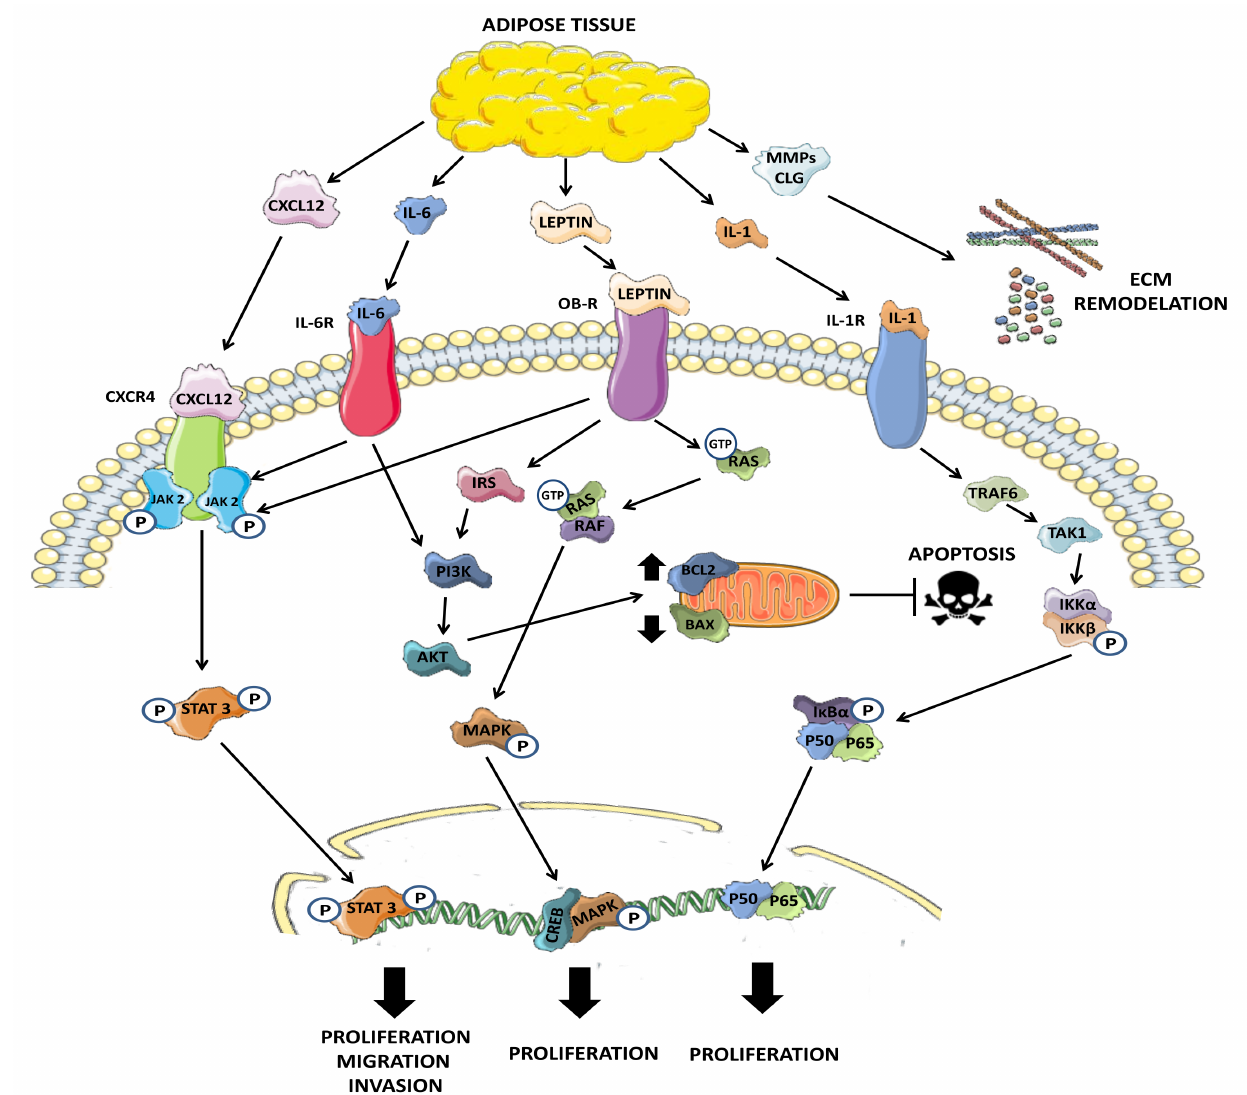
Figure 1. Major routes driving the influence of adipose tissue on tumor progression. Adipose tissue can release adipokines which play important roles in normally altered pathways in cancer. The stromal cell derived factor 1 (CXCL12) through direct interaction with the chemokine receptor CXC type 4 (CXCR4) present in the membrane of tumor cells activates the JAK2/STAT3 signaling cascade, that ultimately has the function of translocation from STAT3 to the nucleus where it acts as a transcription factor for genes involved in cell survival, or migration and invasion, thus promoting EMT. Leptin, another of the main adipokines in adipose tissue, acts by interaction with its membrane receptor (OB-R). This receptor is associated with the JAK2 protein, which in turn phosphorylates STAT3, triggering the activation of survival pathways. Likewise, its interaction with the serine/threonine kinase RAF protein, and the GTPase RAS induce the activation of the MAPK pathway, promoting cell growth and survival. This hormone is also important in the regulation of apoptosis since via PI3K/AKT can modulate the levels of the BCL-2 and BAX proteins, inhibiting apoptosis of tumor cells and thus favoring both proliferation and resistance to chemotherapy. In an inflammatory environment, it is common for the adipose tissue and its microenvironment immune cells to release different interleukins such as IL-6 or IL-1, which by binding to their membrane receptors (IL-6R and IL-1R) are capable to activate the survival pathways mentioned above. IL-1, can also promote proliferation and survival by activating NF κ B-mediated signaling. Finally, adipose tissue can contribute indirectly to the spread of tumor cells through the remodeling of the extracellular matrix mediated by collagenases (CLG) and metalloproteinases (MMPs) which, in conjunction with EMT, favors the migration of cells out of the primary niche and their